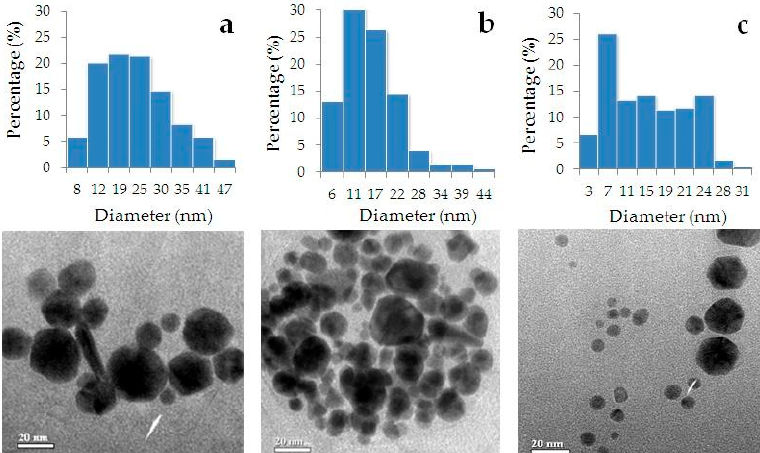
Figure 5. TEM images of phyto-AuNPs synthesized using leaf extracts from gooseberry ( a ), blackcurrant ( b ) and strawberry ( c ), and corresponding histograms of phyto-AuNPs’ size (diameter) distribution. Synthesis conditions: 5 mL of 1 mM HAuCl 4 + 1 mL of extract, time 300 Table 2. Characteristics of the forms of phyto-AuNPs synthesized using leaf extracts from gooseberry, blackcurrant and strawberry (based on TEM data).